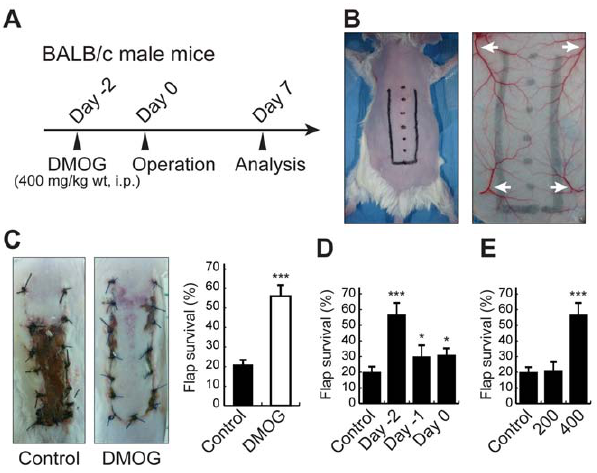
Figure 1. Effect of DMOG pretreatment on expanding survival area of ischemic skin flaps in mice. A, BALB/c mice were randomly assigned to the control group or the experimental group with intraperitoneal DMOG pretreatment (400 mg/kg body weight), fol- lowed by evaluation of flap survival on postoperative day 7. B, Design of ischemic random pattern skin flap and vascular distribution on the mouse dorsum. The flap was designed not to include any major pedicles arising from the deep circumflex iliac vessels and lateral thoracic vessels (white arrows). The distal parts of the flaps exhibited tissue necrosis due to disruption of the blood supply. C, Percentages of the survival area of the flap and dividing by the total area of the flap. Representative ischemic flaps show grossly better flap survival in the DMOG group. D, Effects of timing of DMOG pretreatment on the expansion of flap survival. DMOG pretreatment was performed 2 days or 1 day before the surgery or on the day of the surgery. E, Effect of dose of DMOG pretreatment on the expansion of flap survival. DMOG pretreatment was performed 2 days prior to surgery. The percentages of flap survival 6 SEM were measured on postoperative day 7. * P . 0.05; *** P . 0.001.